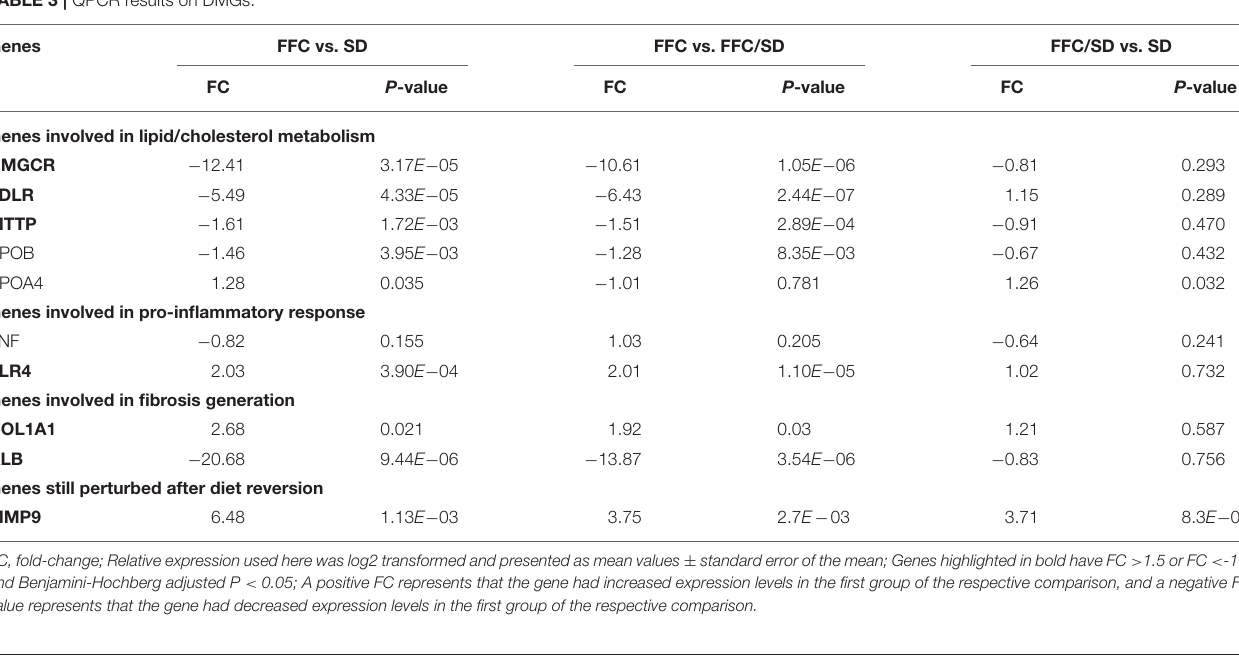
TABLE 3 | QPCR results on DMGs. Genes FFC vs. SD FFC vs. FFC/SD FFC/SD vs. SD